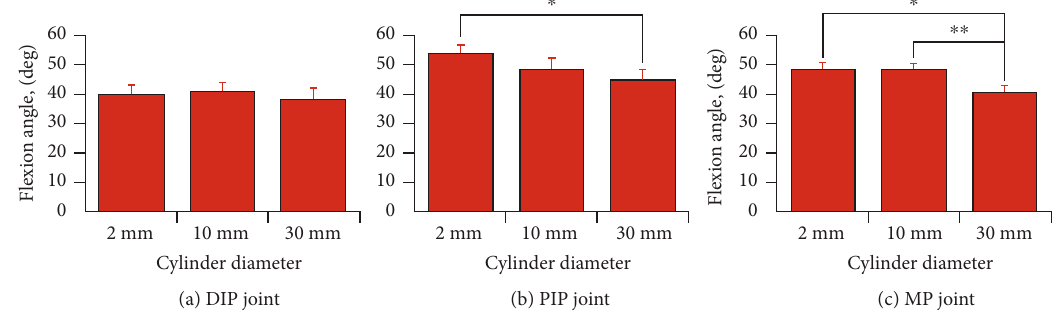
Figure 3: Mean fl exion angle of each index fi nger joint when cylinders of di ff erent diameters were pinched. ∗ p < 0 : 05 , ∗∗ p < 0 : 01 . The error bars indicate the standard